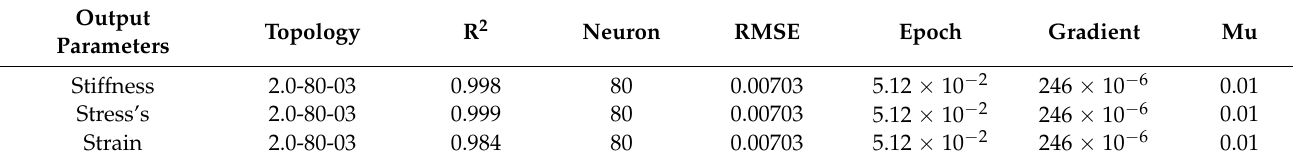
Table 3. Topology and characteristics of an optimal ANN model.